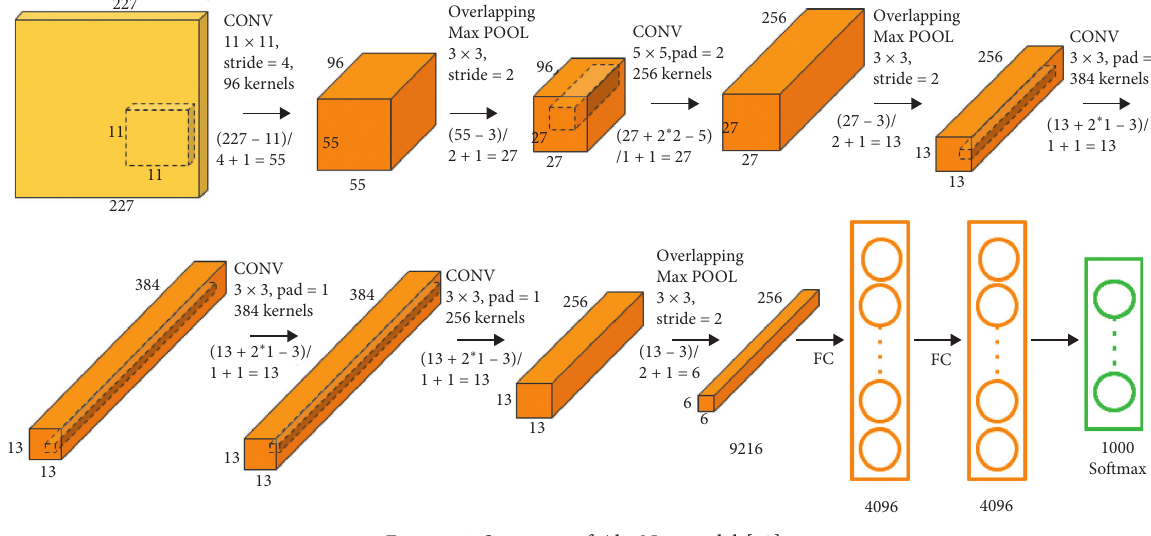
Figure 1: Structure of AlexNet model [12]. Table 2: Parameters detail of AlexNet model.